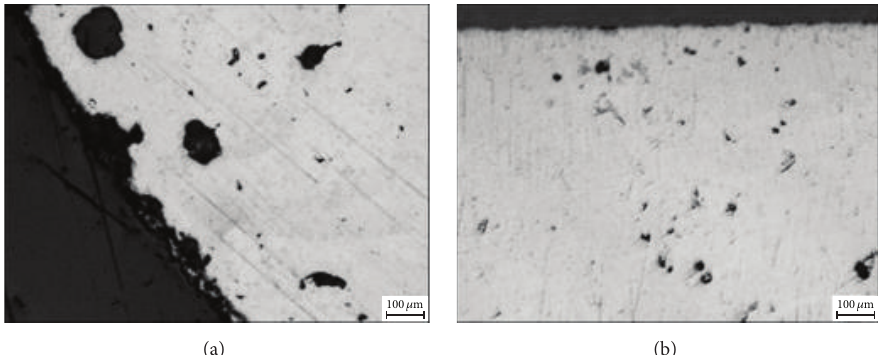
Figure 8: Optical micrographs at the outer region of (a) sample E ( − 325 mesh) and (b) sample F (+50 mesh and − 325 mesh) sintered at 1150 ∘ C for 80 min.